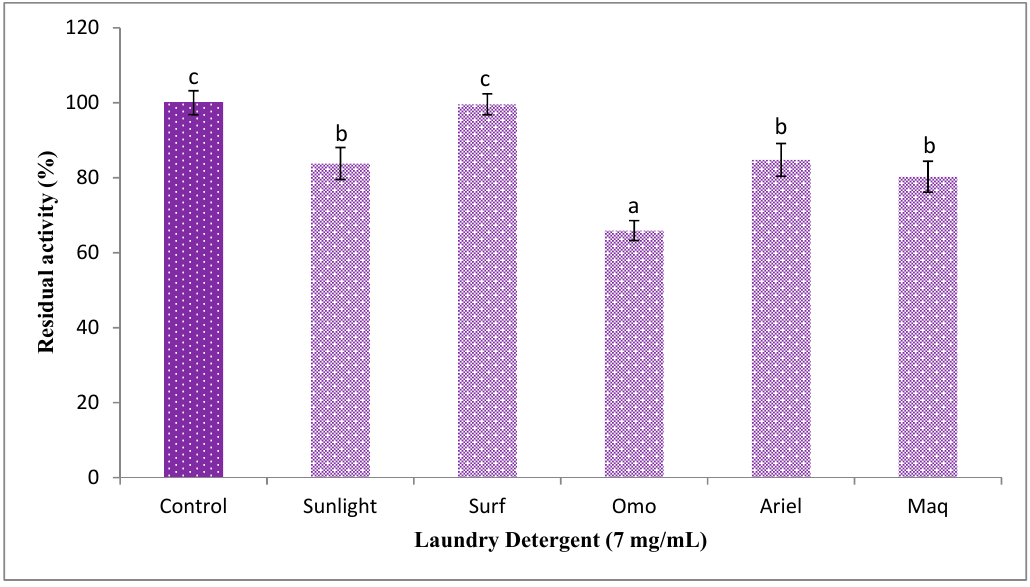
Figure 9. Impact of laundry detergents on KerBNK1 stability. a, b and c indicate statistically significant di ff erence among the di ff erent tests; and treatments without similar letter(s) are significantly di ff erent ( p <